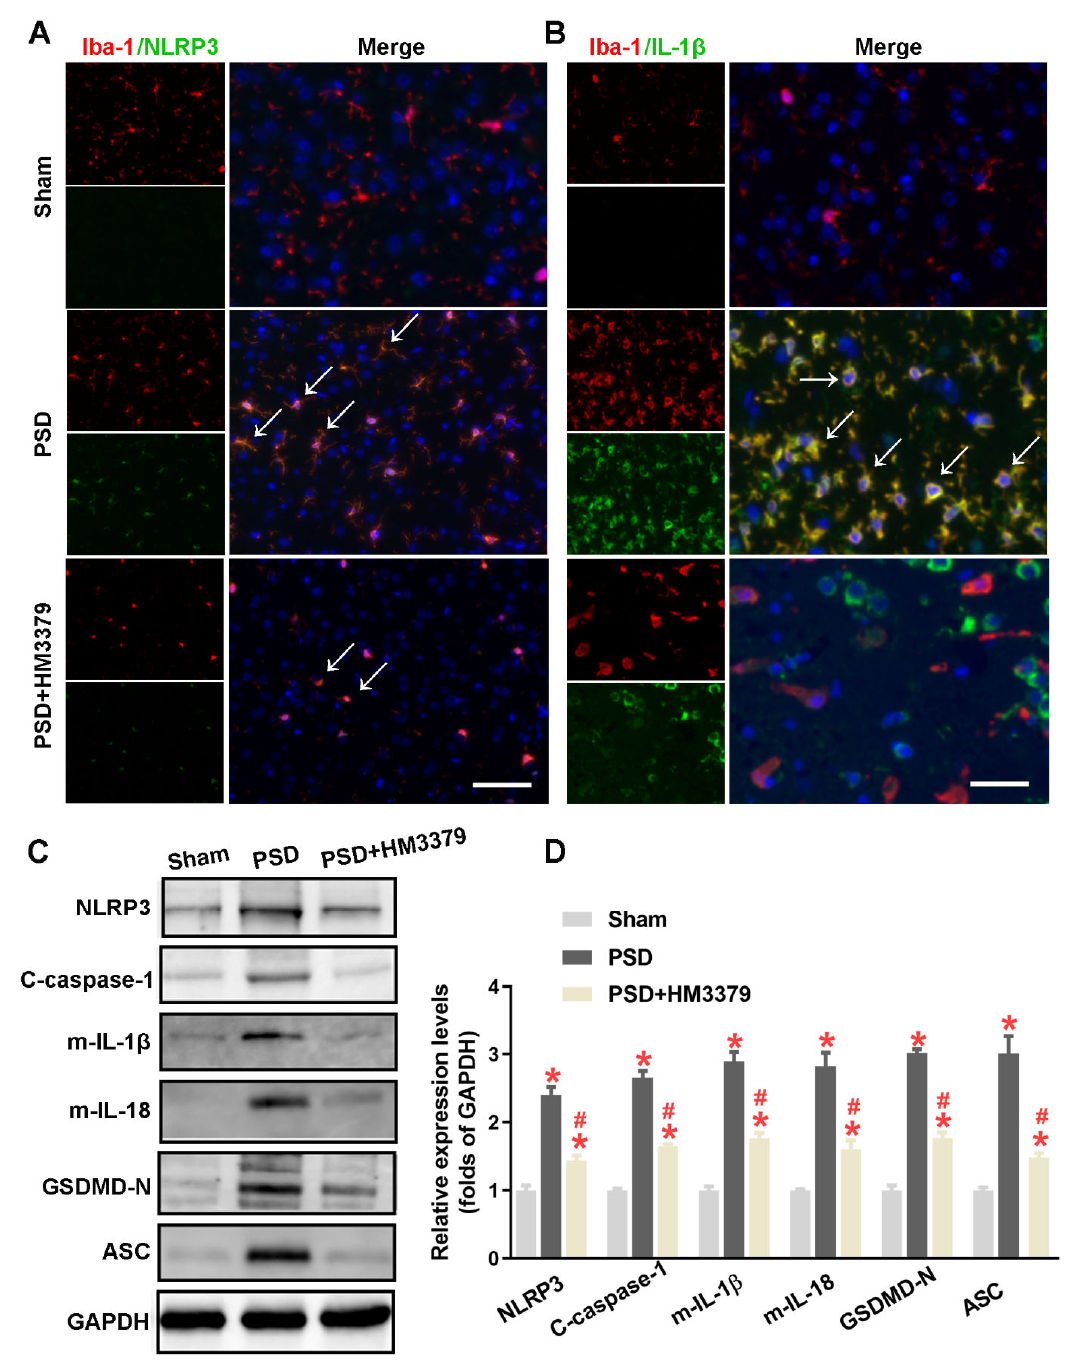
Figure 3. HM3379 blocked PSD-induced activation of the NLRP3 inflammasome and pyroptosis in gerbils. ( A ) Immunofluorescence staining of Iba-1 (red) and NLRP3 (green) revealed NLRP3 expression in microglia. ( B ) Brain sections were stained with IL-1 β (green), as well as Iba-1 (red) or Dapi (blue), to monitor IL-1 β accumulation. White arrows point to NLRP3-positive or IL-1 β -positive in microglia on day 14 after tGCI. ( C ) Western blot analysis of the expression of NLRP3, cleaved caspase-1, mature IL-1 β , mature IL-18, GSDMD-N, and ASC in sham, PSD, and PSD + HM3379 group. ( D ) Combined Western blot statistics. Data are expressed as mean ± SEM. * indicates p < 0.05 vs. sham, # indicates p < 0.05 vs. PSD. N = 3 per group. Scale bars = 50 µ m. PSD, post-stroke depression. tGCI, transient global cerebral